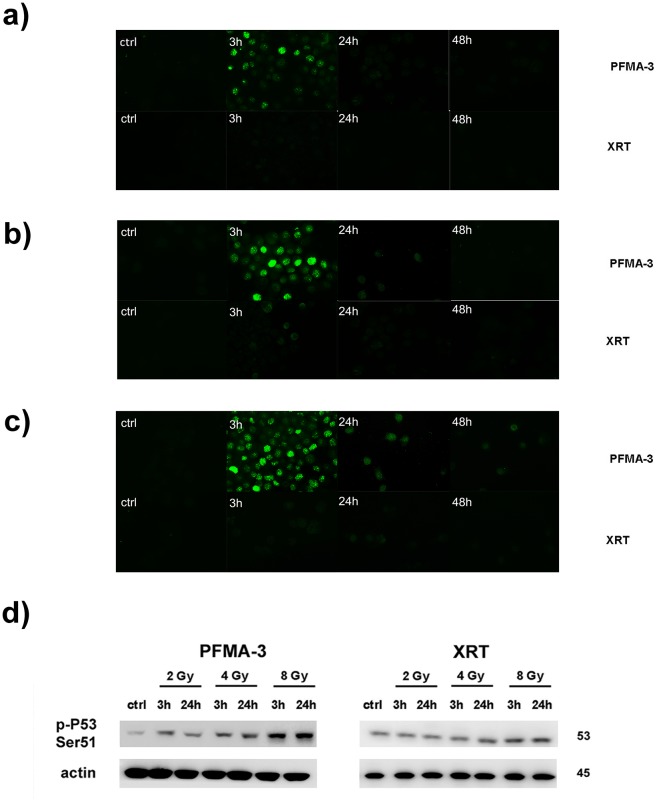
PFMA-3 causes a DNA-DSB more severe with respect to XRT in A375.Induction of DSB was assessed through detection of phosphorylation of H2A.X at Ser139 (green) by immunofluorescence and microscopy analysis. a) DSB after 2 Gy treatment. b) DSB after 4 Gy treatment. c) DSB after 8 Gy treatment. ctrl, control cells. d) Western blot analysis documenting phospho-p53 (Ser51) levels modulation in PFMA-3 and XRT irradiated samples. Antibody to b-actin served as a loading control. ctrl, control cells.